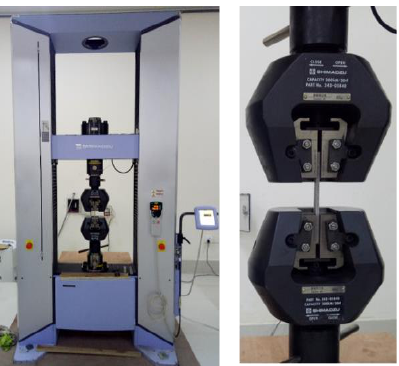
Figure 3: Universal testing machine with tensile testing grip and